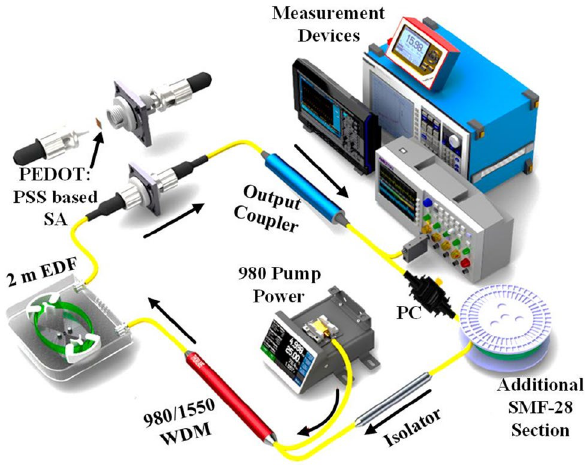
Figure 3. Laser configuration of the mode-locked EDFL operation.